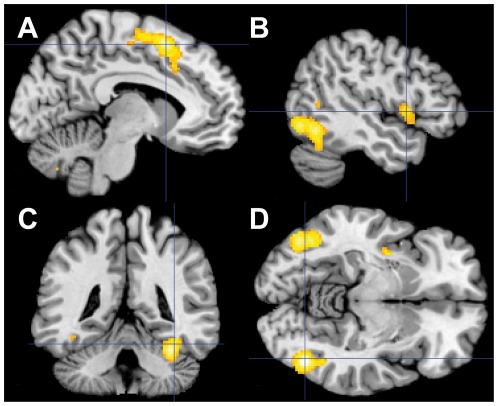
Areas recruited more strongly in response to emotional as compared to non-emotional conflict.(A) The emotional interference task, as compared to the non-emotional task, led to a stronger recruitment of the posterodorsal medial frontal cortex encompassing Brodman areas 8, 6, 32 and 24. The intersection is in left SMA (MNI coordinates: x = −8, y = 12, z = 54). (B) Stronger recruitment of left IFC/anterior insula region (MNI coordinates: x = −48, y = 8, z = 0) and the left occipitotemporal visual cortex. (C) Recruitment of the right fusiform face area (MNI coordinates: x = 36, y = −44, z = −22). (D) Bilateral recruitment of the bilateral occipitotemporal visual cortex. Intersection is in the right inferior temporal gyrus (MNI coordinates: x = 44, y = −68, z = −10). Activity is shown at P<0.05 (cluster-level family-wise error-corrected; cluster-forming threshold at voxel-level P<0.001).